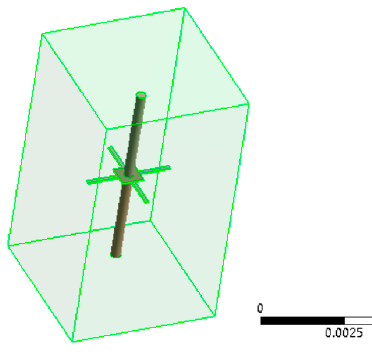
Figure 7. Modal analysis model. Table 1. Parameters of the materials.